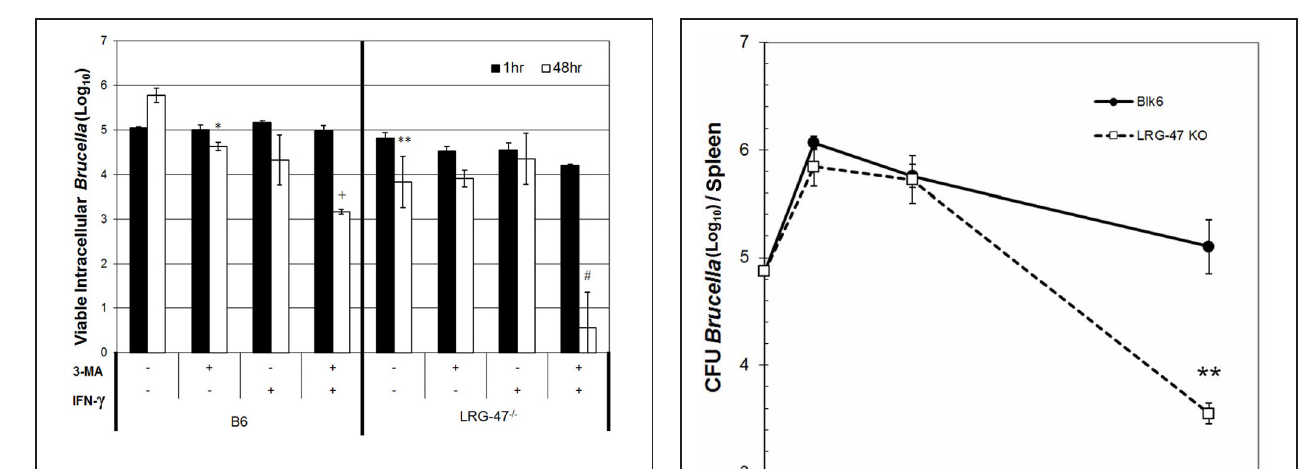
FIGURE 4 | Brucella survival in LRG47 − / − macrophages is unaffected by the autophagy inhibitor 3-methyladenine (3-MA). Peritoneal macrophages were collected from C57/B6 and LRG-47 − / − mice and infected with Ig-opsonized virulent B. abortus . Cells were stimulated with IFN- γ and treated with 50 μ M 3-MA. Colony forming units were enumerated at 1h and 48h post infection. Loss of LRG-47 in non-activated cells had a similar effect as treatment with 3-MA or IFN- γ in C57/B6 cells on Brucella survival after 48h. The inhibition of autophagy plus IFN- γ activation greatly decreased the number of viable Brucella after 48h in LRG-47 − / − cells. Statistical significance of Student’s T -test comparing C57/B6 non-stimulated 48h controls CFUs to indicated groups; p values ∗ < 0 . 05; ∗ < 0 . 01, comparison to C57/B6 IFN- γ only p + < 0 . 01. Statistical comparison to non-stimulated LRG-47 − / − control p value # < 0.001.